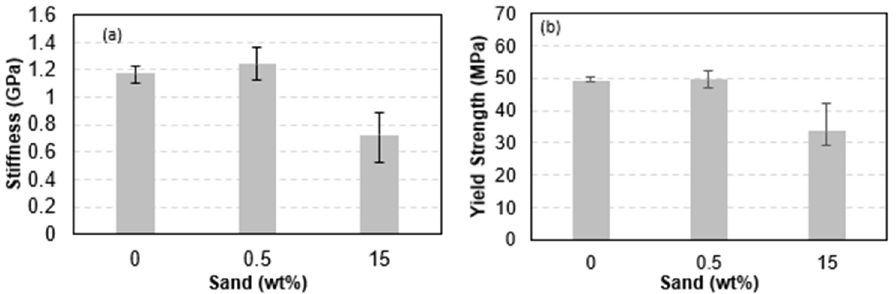
Figure 16. Properties of 3D printed PLA-sand compression cylindrical samples, showing ( a ) stiffness and ( b ) yield strength.